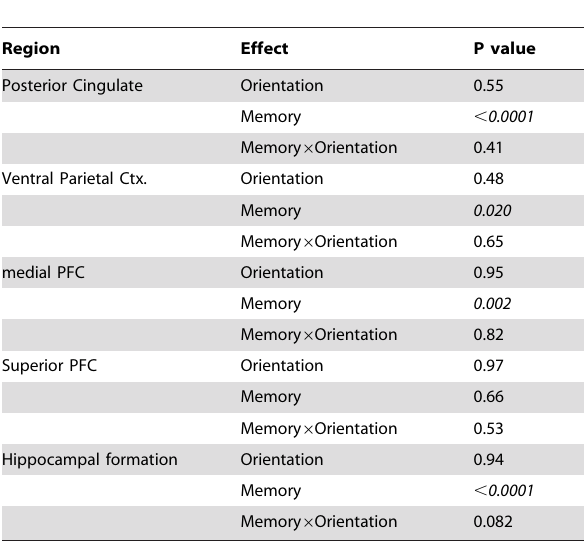
Table 2. Regions identified in resting-state analysis. Region Hemisphere BA Z Posterior Cingulate Ctx. Ventral Parietal Ctx. Medial Prefrontal Ctx. Superior Prefontal Ctx.